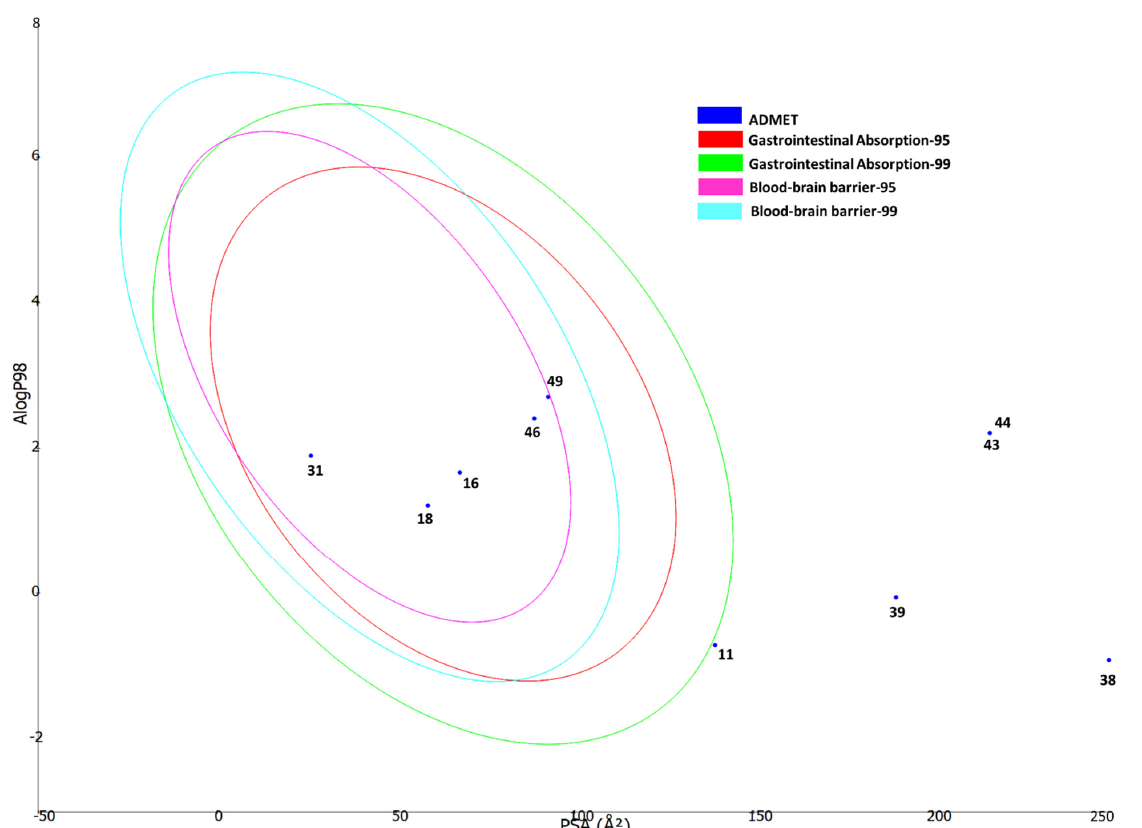
Figure 8. ADMET properties of the bioactive constituents from Alcea fasciculiflora predicted using Biovia DS ADMET prediction module. The four ellipses define regions where well absorbed com- pounds are expected to be located: for gastrointestinal absorption at 95 and 99% (red and green) confidence levels, and for blood-brain barrier penetration (BBB) at 95 and 99% (magenta and aqua) confidence levels. All compounds are shown according to their serial number in Table 2.